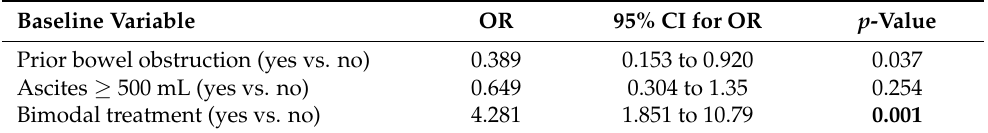
Table 2. Multivariable logistic regression analysis correlating with completion of the per protocol